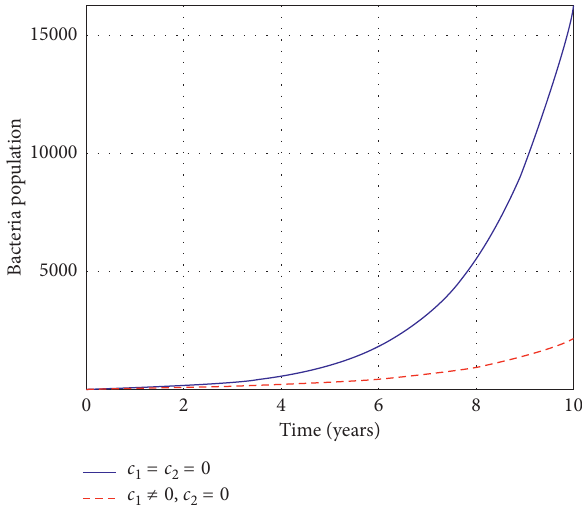
Figure 7: A graph showing the effectiveness of the two control and c in the bacteria population to check its effect on measures c 1 2 the spread of cholera.